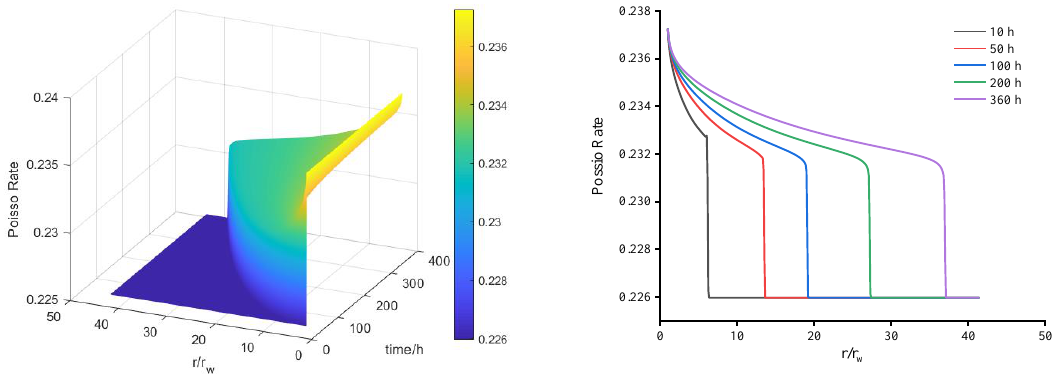
Figure 5. Variation of Poisson’s ratio with dimensionless distance and time.